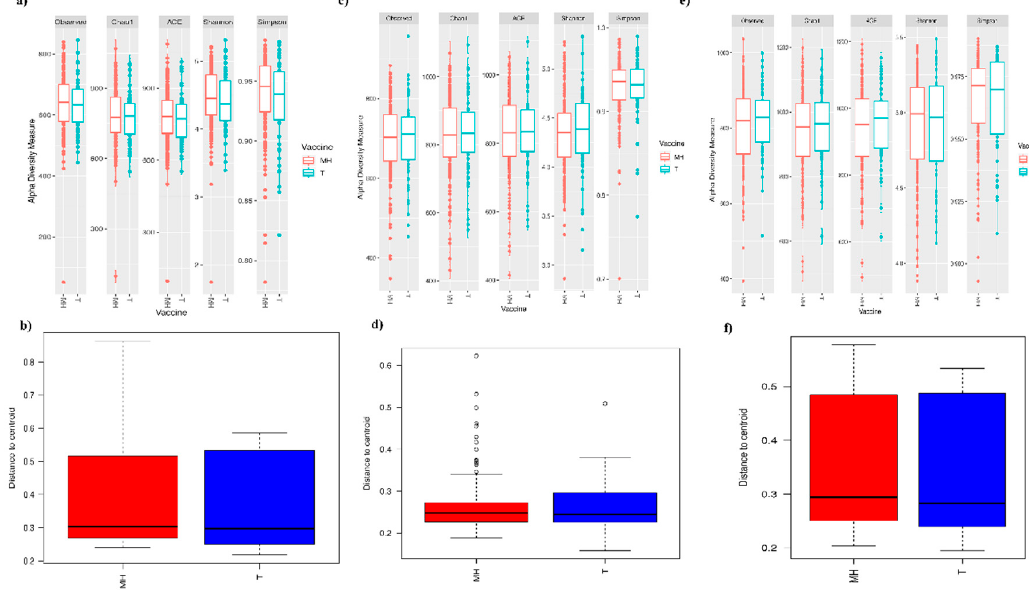
Figure 3. Diversity analysis between the vaccinated and non-vaccinated pigs at three post-vaccination time points; 21, 35, and 118 dpv. ( a ) Alpha diversity indices, comparing vaccinated (MH) vs. non-vaccinated (T) pigs at 21 dpv, ( b ). Box plot representing the values of the distances to centroid for the vaccinated (MH) and non-vaccinated (T) pigs at 21 dpv; ( c ) alpha diversity indices, comparing vaccinated (MH) vs. non-vaccinated (T) pigs at 35 dpv ( d ). Box plot representing the values of the distances to centroid for the vaccinated (MH) vs. non-vaccinated (T) pigs at 35 dpv; ( e ) alpha diversity indices, comparing vaccinated (MH) vs. non-vaccinated (T) pigs at 118 dpv; ( f ). box plot representing the values of the distances to centroid for the vaccinated (MH) vs. non-vaccinated (T) pigs at 118 dpv. For the alpha diversity, ANOVA and Tukey’s honest tests were used to assess the differences . Distances to centroid were calculated using the “betadisper” function of the vegan R package. No significant differences observed.